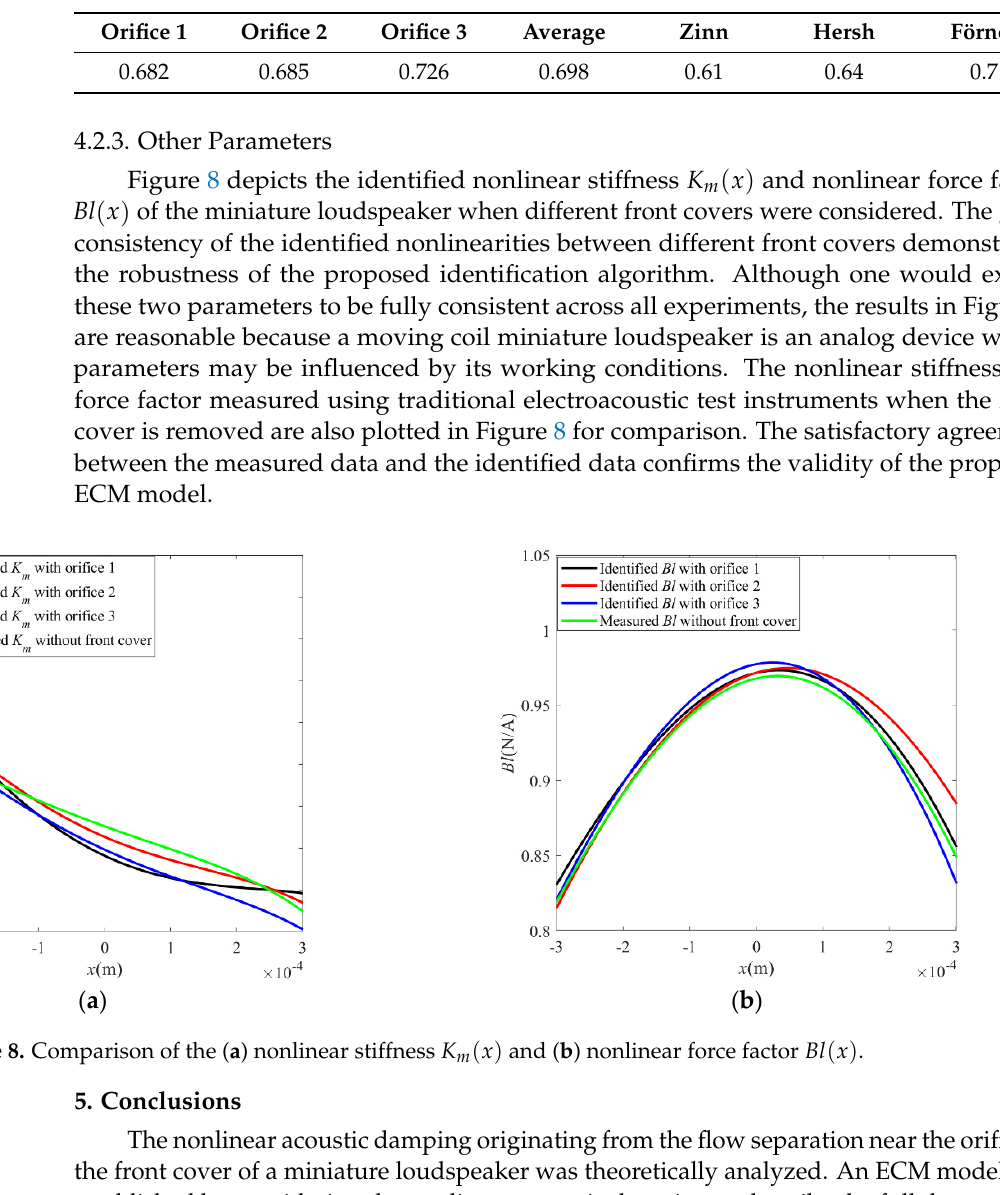
Table 2. Discharge coefficients obtained from system identification.